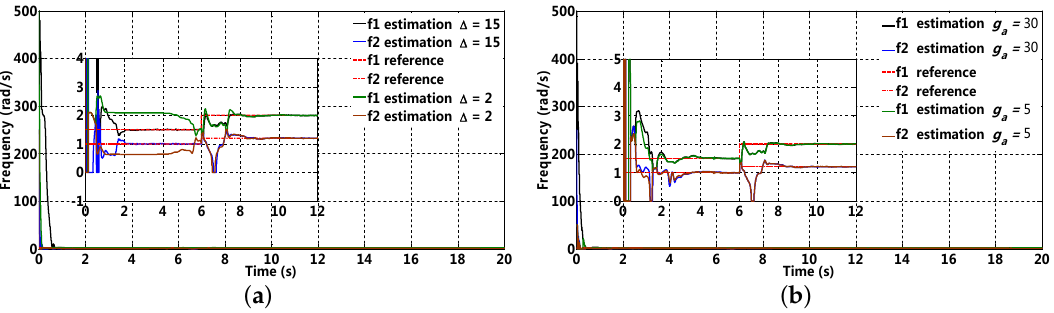
Figure 13. Frequency estimation with respect to parameter ∆ and g a : ( a ) parameter ∆ ; ( b ) parameter g a